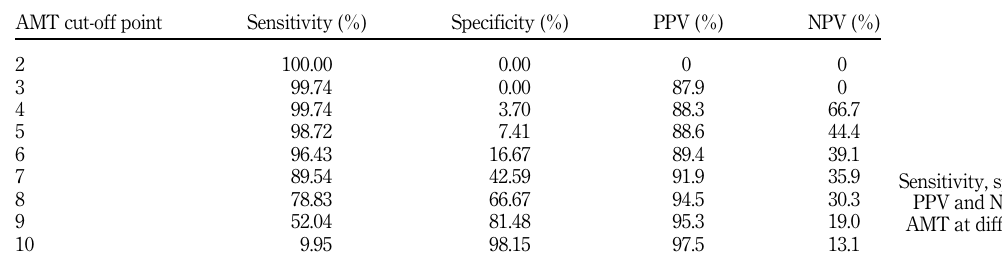
Figure 1. Bland – Altman plot between AMT and MMSE %